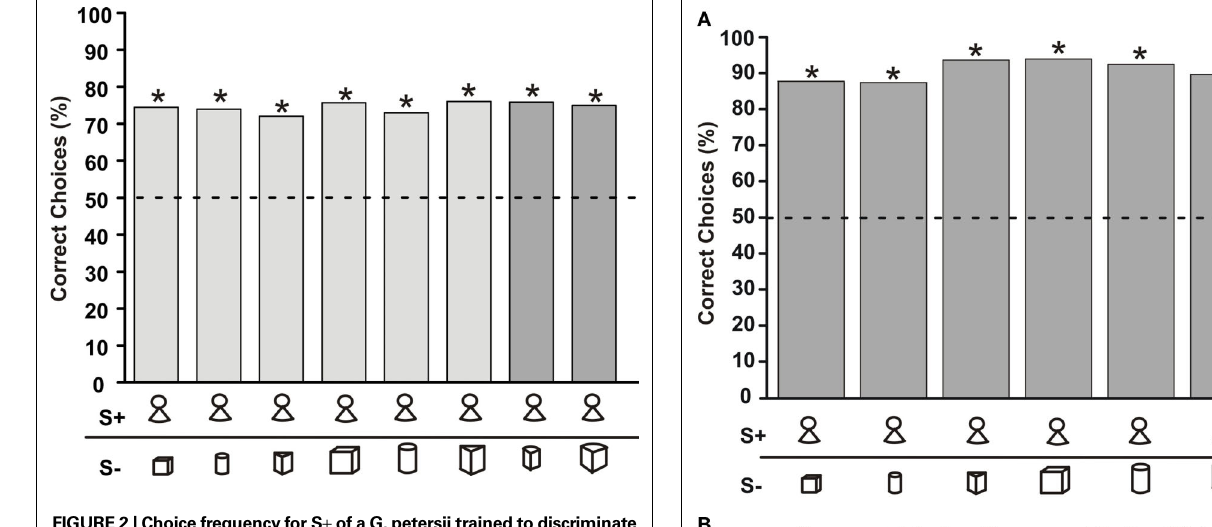
FIGURE 2 | Choice frequency for S + of a G. petersii trained to discriminate between a fi xed S + (‘little man’) and six differently shaped objects. Light grey bars represent choice frequency when known S − objects were used, while dark grey bars depict the choice frequency when previously unknown objects were paired with the S + . The symbols below each bar indicate the object combinations ( Table 1 ) used ( n > 264 for each combination, asterisks indicate signifi cant choice on the 5% level as evaluated using the Chi-square test). Here and in the subsequent fi gures, choice frequency for S + was determined in non-rewarded and non-punished test trials.